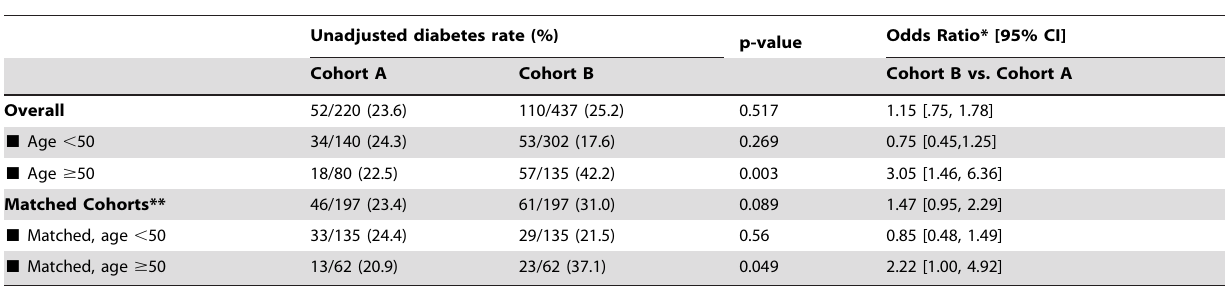
Table 2. Rates of diabetes overall and by age group and cohort.